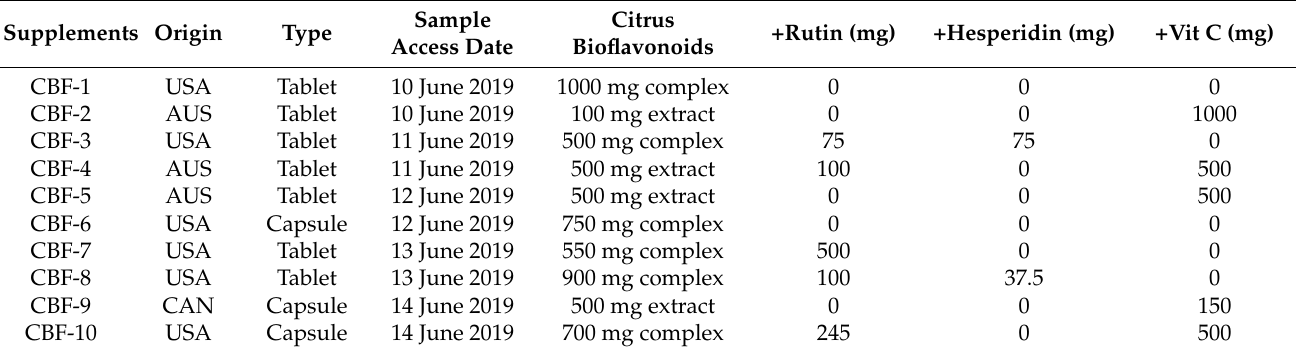
Table 1. Commercial supplements investigated in this study and their claimed citrus bioflavonoid content from crude citrus (extract or complex) and additional